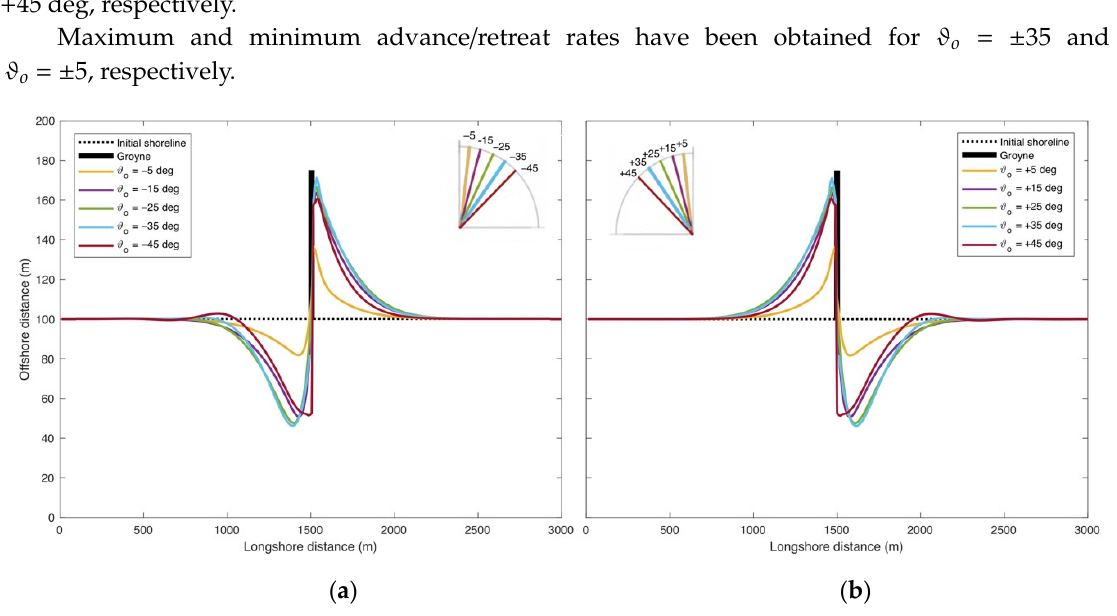
Figure 5. Calculated shoreline evolution for ( a ) ϑ o = − 45, − 35, − 15, − 5 and ( b ) ϑ o = + 5, + 15, + 25, + 35, + 45. Maximum and minimum advance/retreat rates have been obtained for (cid:2036) (cid:3042) = ± 35 and (cid:2036) (cid:3042) = ± 5, respectively.